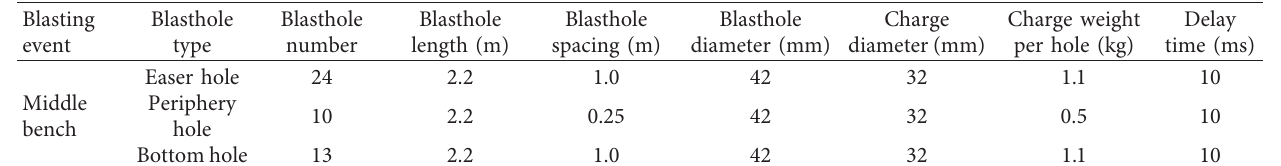
Figure 4: Layout of typical blasthole for electronic detonators of the tunnel. Table 1: Blasting parameters of the middle bench.